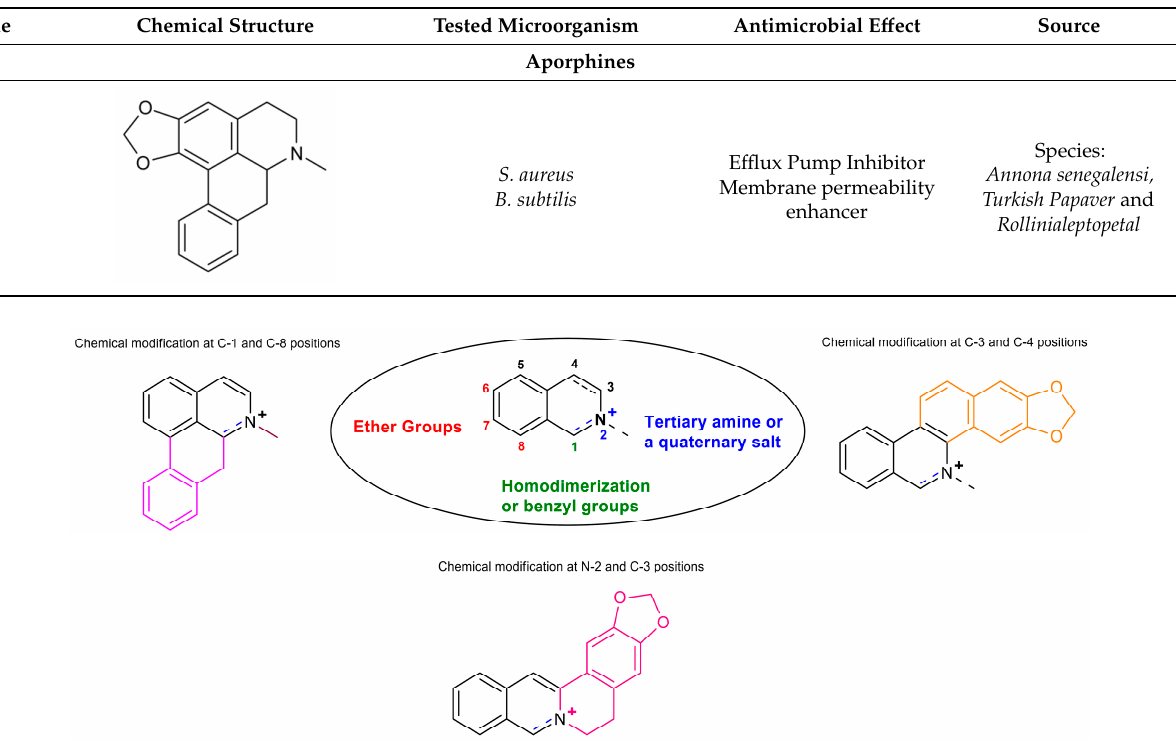
Figure 4. Beneficial modifications of the isoquinoline alkaloids based skeleton.